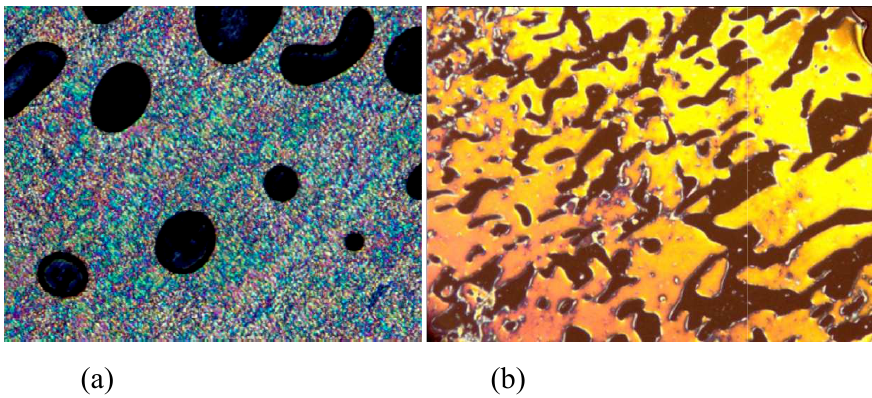
Figure 2 . Micrographs of smectic A (a) and nematic ( Gd(CPDk ) Bpy 3−5 3